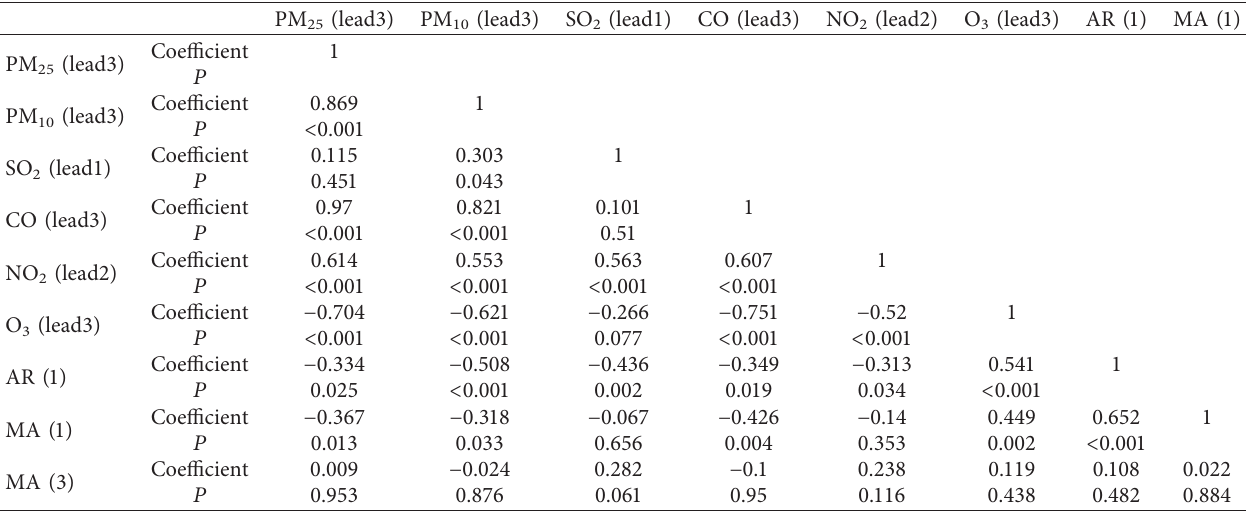
Table 6: The results of Pearson’s correlation analysis between independent